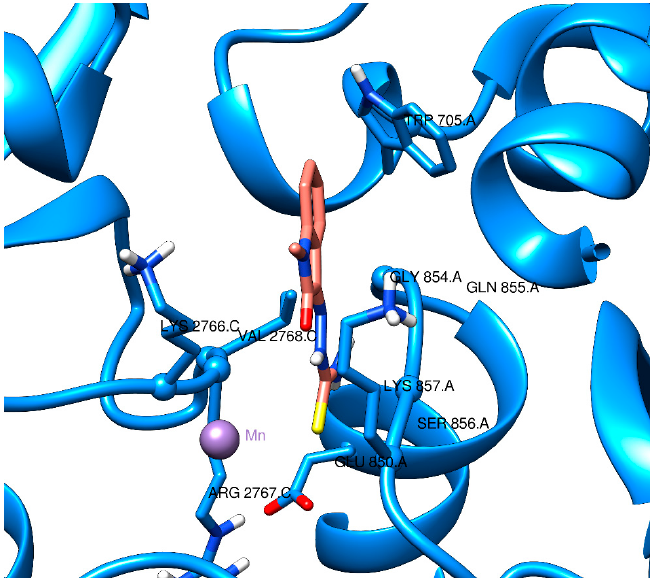
Figure 6. Visualization of docking of Mn–MSZ in 6VYB. Molecular graphics and analyses per- formed with UCSF Chimera, developed by the Resource for Biocomputing, Visualization, and Informatics at the University of California, San Francisco, with support from NIH